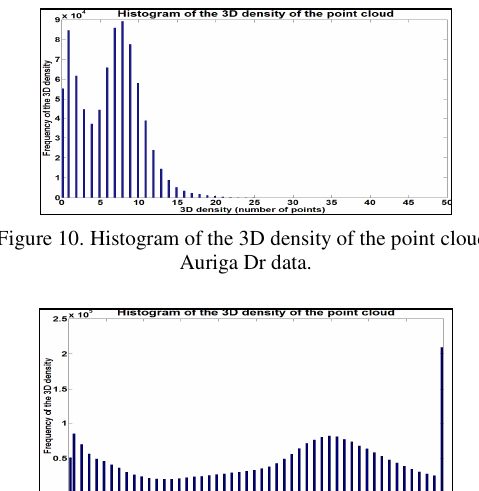
Figure 7. 3D density of Dalhousie St data.